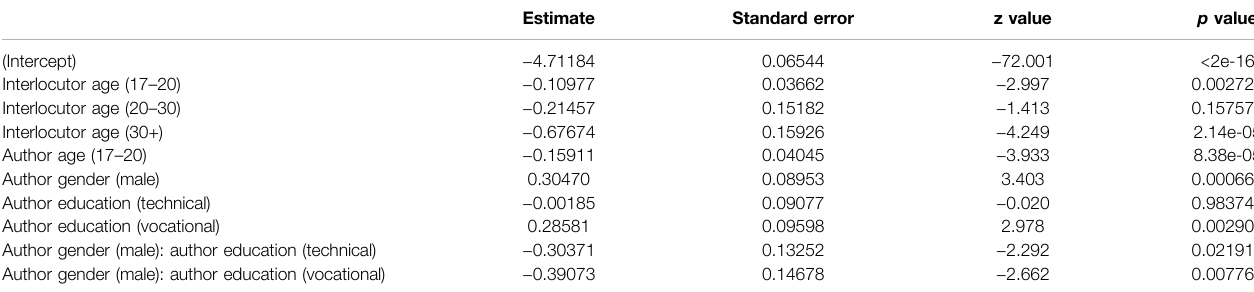
TABLE 8 | Brevity per interlocutor age: Fixed effects 13 .